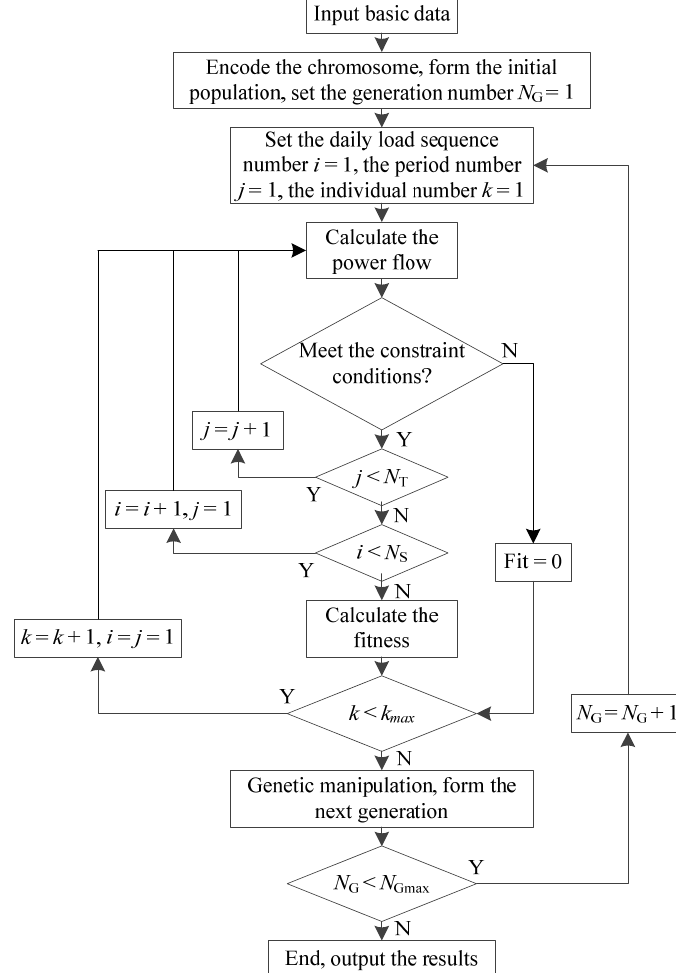
Figure 6. Flow chart of the proposed algorithm based on